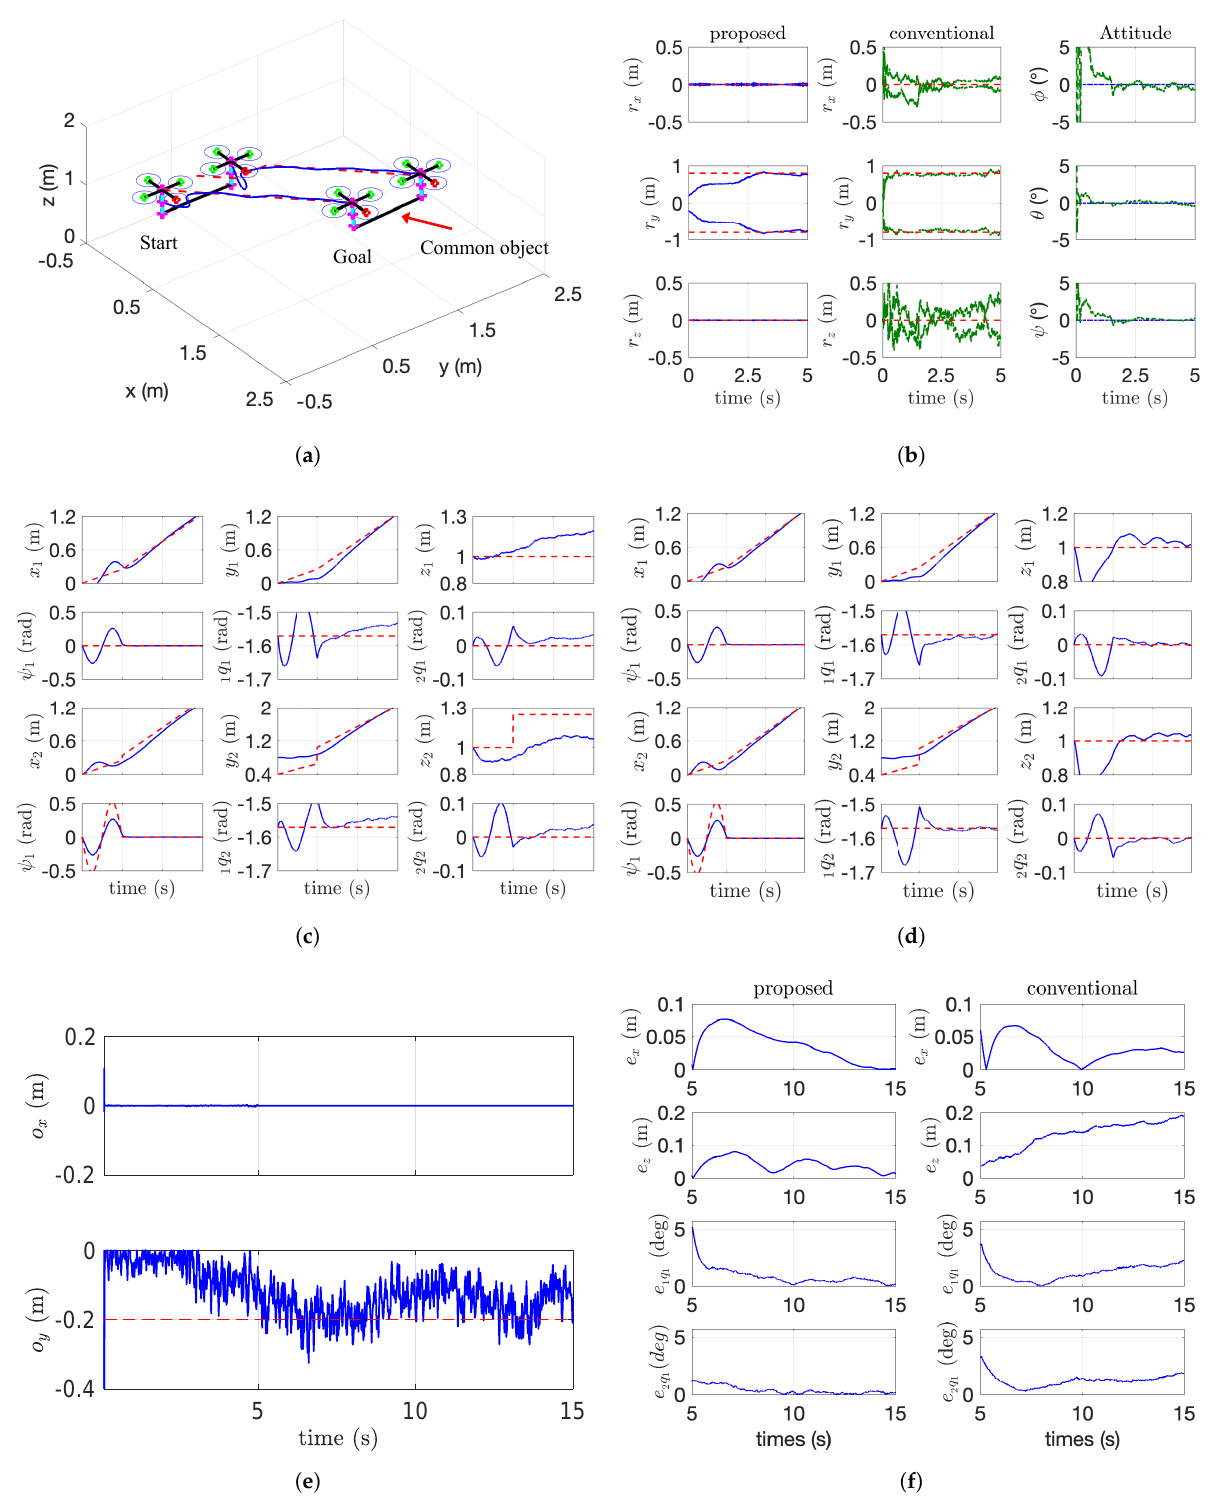
Figure 6. Trajectory tracking of a cooperative aerial manipulators. ( a ) 3D flight scenario. ( b ) Kinematic parameter estimation. ( c ) by the conventional algorithm. ( d ) by the proposed algorithm. ( e ) Estimation of o x and o y . ( f ) Tracing error